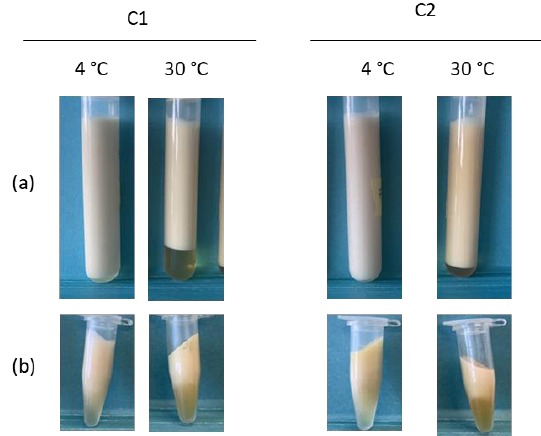
Figure 8. ( a ) Emulsification index over storage temperature after 45 days; ( b ) centrifugation test over storage temperature after 45 days. Table 4. Physicochemical characterization of formulation C1 and C2 during 45 days of storage at 4 °C, and 30 °C. ƞ at 2.30 s −1 .